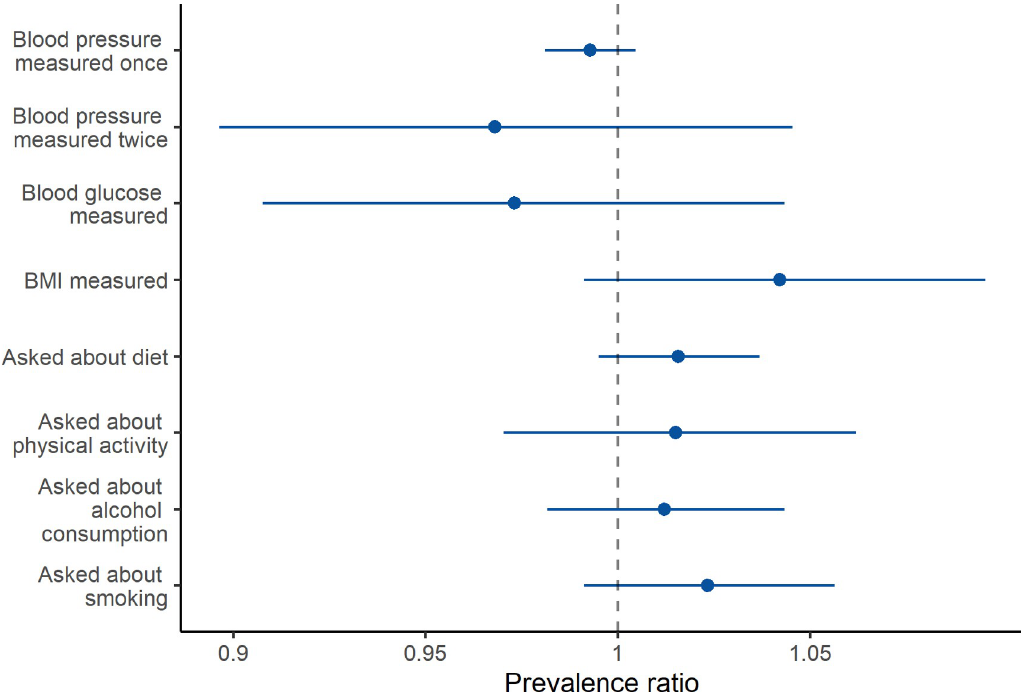
Fig 3. Association between years practicing and CVD care actions based on univariate Poisson regression. Coefficients are presented as prevalence ratios associated with a 1-year increase in experience. Error bars represent 95% confidence intervals.